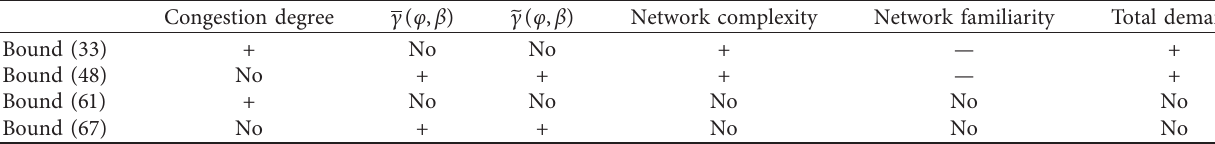
Table 2: Effects of various parameters on the upper bounds.